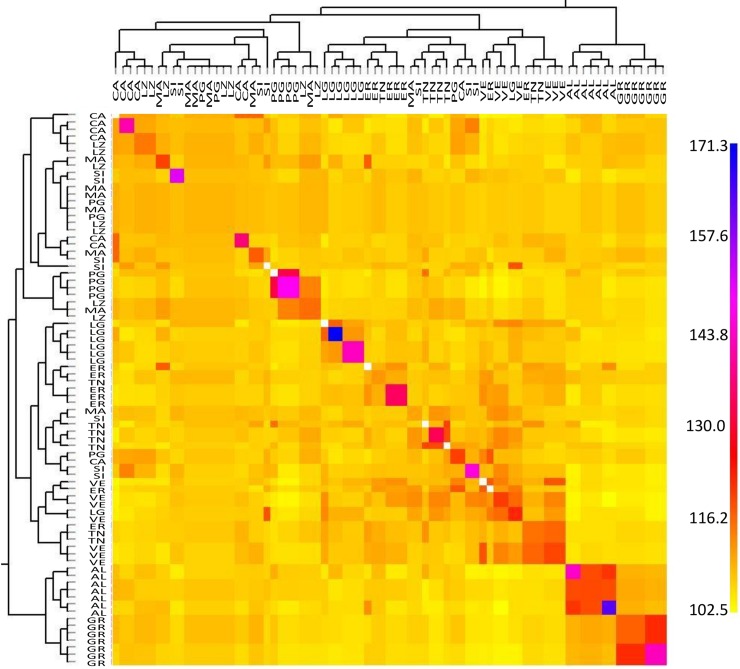
Co-ancestry heat map for the 2016-dataset (N SNPs = 4,094).Heat map was obtained using the unlinked model in fineSTRUCTURE. The heat map shows the number of shared genetic chunks between the individuals. Co-ancestry scale is shown at the right with the lowest value in yellow and the highest in blue. The tree next to the heatmap shows the inferred relationships between the 77 specimens analyzed, with each tip corresponding to an individual. Populations are encoded as in Table 1.